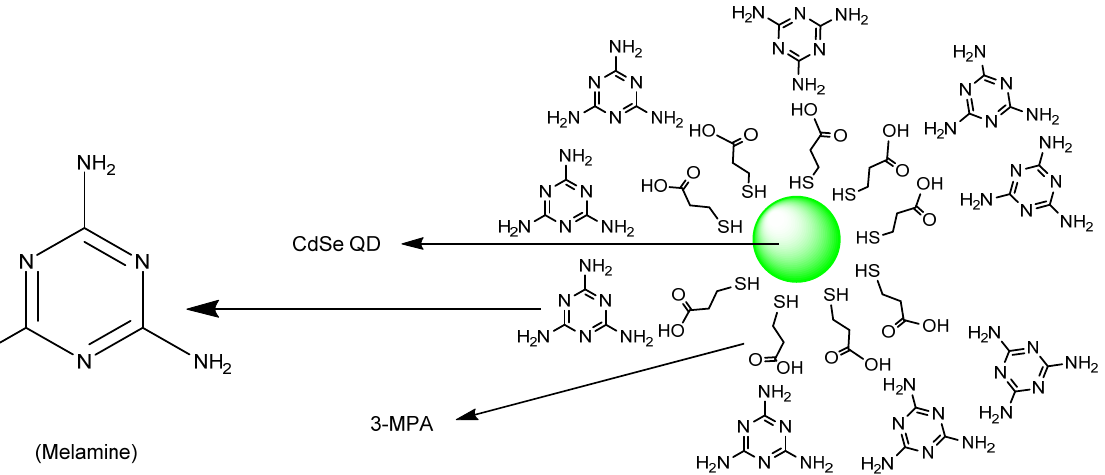
Figure 66. Structure of m–CdSe and its action for the detection of melamine by Singh et al. Rao et al. designed an Hg 2+ –based probe placed on ZnO nanorod and doped with elemental selenium and coated with 3–mercaptopropionic acid (3–MPA). The ZnO nanorods doped with selenium are sized around 50 nm and have strong orange–red fluorescence centered at 625 nm (Figure 67). Selenium was selected because it can induce fluorescence emission. The fluorescence appears because of the presence of interstitial oxygens and crystal lattice defects. The quantum yield for the ZnO nanorod doped with selenium is ( Φ F ) 0.15, as calibrated with DAPI as standard ( Φ F = 0.043) as. The ZnO nanorod doped with selenium that has been functionalized with 3–MPA was studied at various values of pH, temperature, and storage time; its sensitivity and selectivity also are applied to determine Hg 2+ in real water samples. The result is that it works optimally at pH 7.0; this is due to the fact that, under acidic pH, the MPA ligand becomes protonated and released from the ZnO nanorod doped with selenium at its surface. Conversely, in the basic pH region, ZnO nanorods will enable the formation of metal hydroxide groups and it loses its functionality to detect Hg 2+ . Higher temperatures can also make 3–MPA ligands separate from ZnO nanorods doped with selenium because of the administration of large thermal energy. In storage time, even after 6 months the fluorescence emitting from this probe remains the same; this is telling of the integrity of such materials. Within the addi- tion of Hg 2+ , the 3–MPA that quenches the fluorescence is separated from the surface of the ZnO nanorod doped with selenium. The resulting increase in fluorescence for at least 30 s was followed by the decrease of fluorescence due to the aggregation and instability of a ZnO nanorod doped with selenium. The probe has a noted extraordinary sensitivity involving a LOD of 1 pm; the selectivity for Hg 2+ in the presence of heavy metal ion inter- ferents, even when they are at a high concentration was noteworthy. The probe can also be used to detect Hg 2+ in real samples in which the recovery rate was measured to be between 93–99% [111].